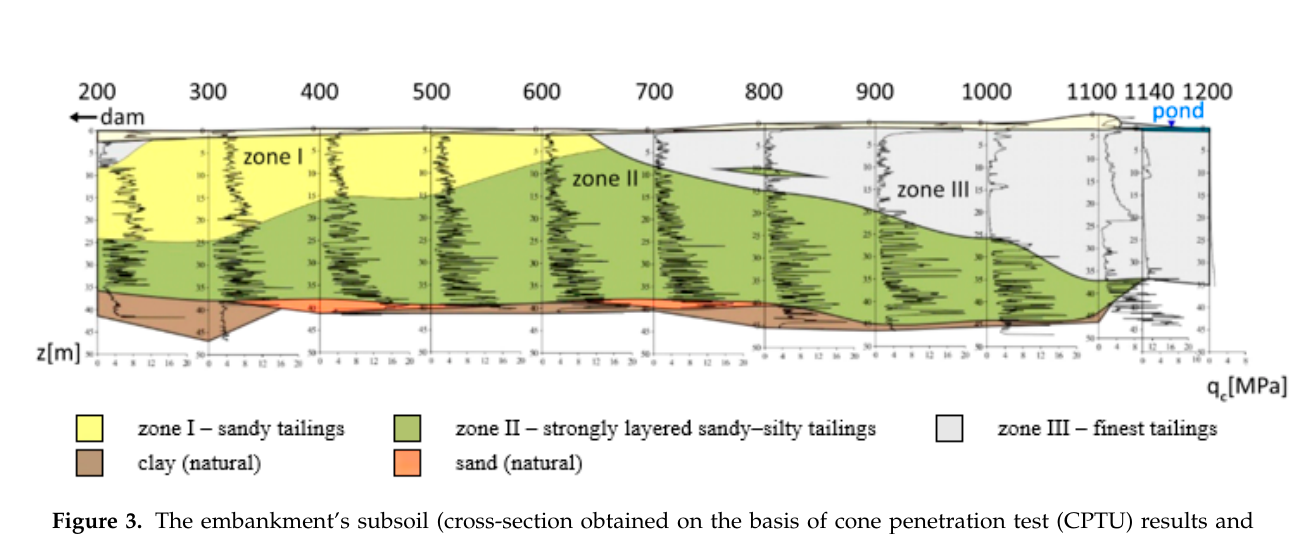
Figure 3. The embankment’s subsoil (cross-section obtained on the basis of cone penetration test (CPTU) results and laboratory analysis of tailings grain size; zones as indicated in Table 1).